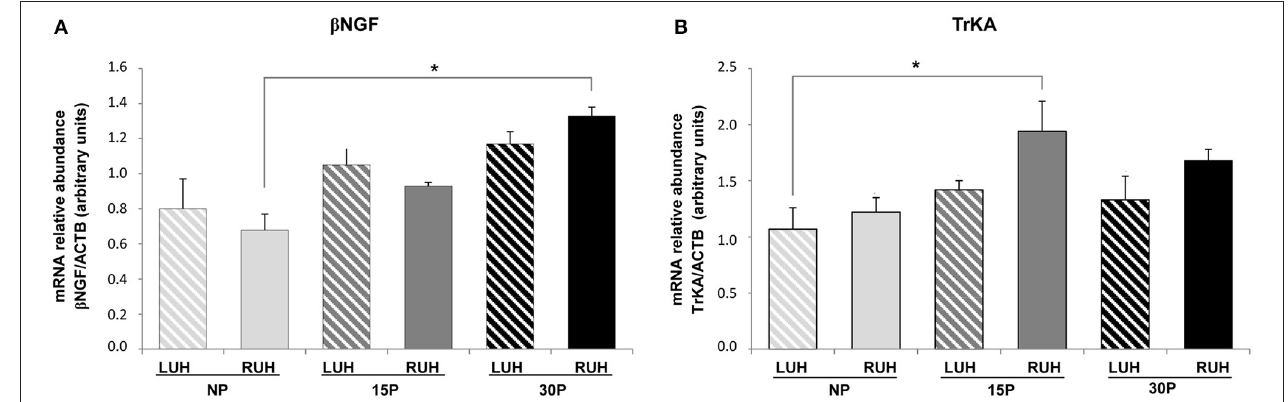
FIGURE 1 | Relative abundance of β -NGF (A) and TrKA (B) transcripts in the endometrium of non-pregnant (NP), 15 days-pregnant (15P), and 30 days-pregnant (30P) alpacas by RT-PCR. Histograms illustrate mean values ± SE. Asterisks denote significant differences (* p < 0.05 ). LUH (left uterine horn) and RUH (right uterine horn).